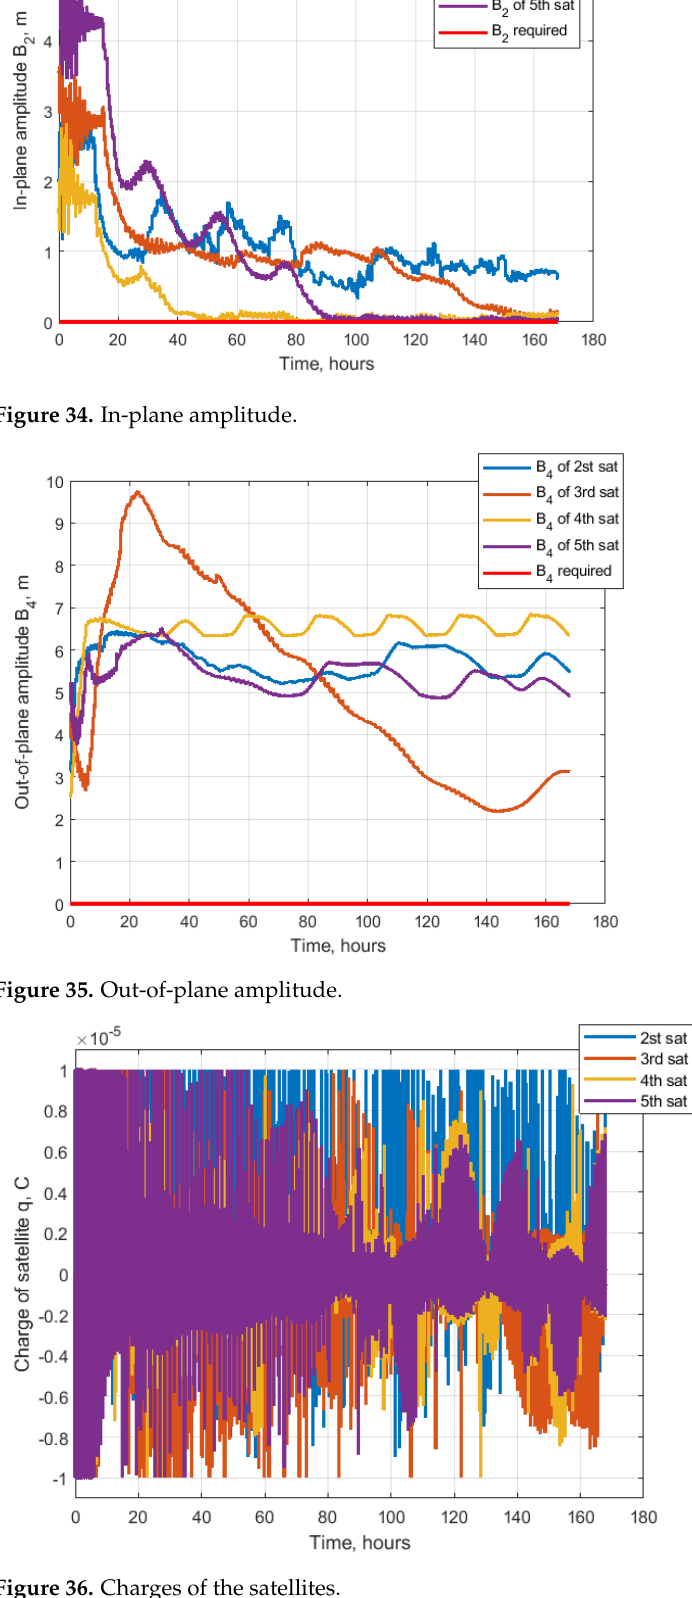
Figure 36. Charges of the